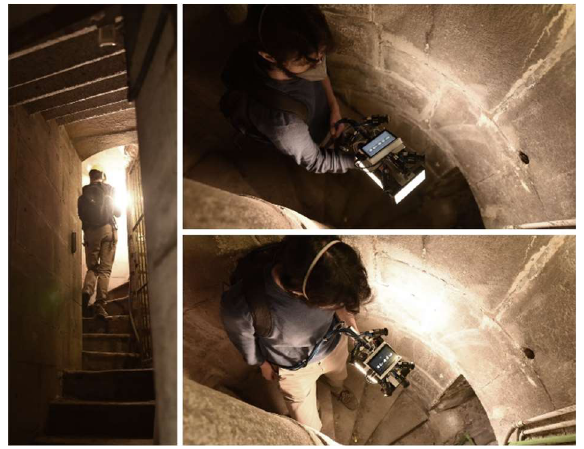
Figure 3. On field acquisitions inside a narrow spiral staircase. Figure 4. Section view of the calibration testfiled used (left), and two images acquired by the multi-camera system (right).